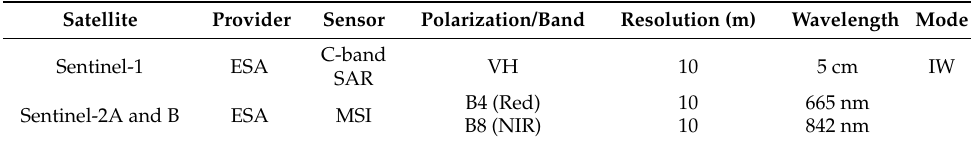
Table 1. Characteristic of the satellite data used in this study. Satellite Provider Sensor Polarization/Band Resolution (m) Wavelength Mode Sentinel-1